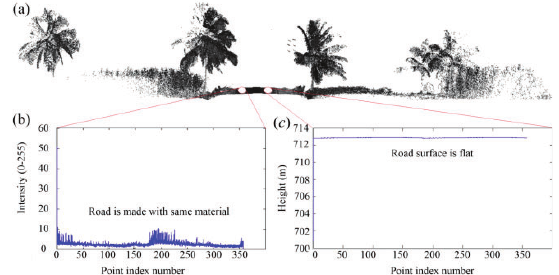
Figure 4. (a) Perspective view of MTLS data cross section across the MTLS path (b) intensity variation of neighbors of road surface, (c) height variation of neighbors of road surface.